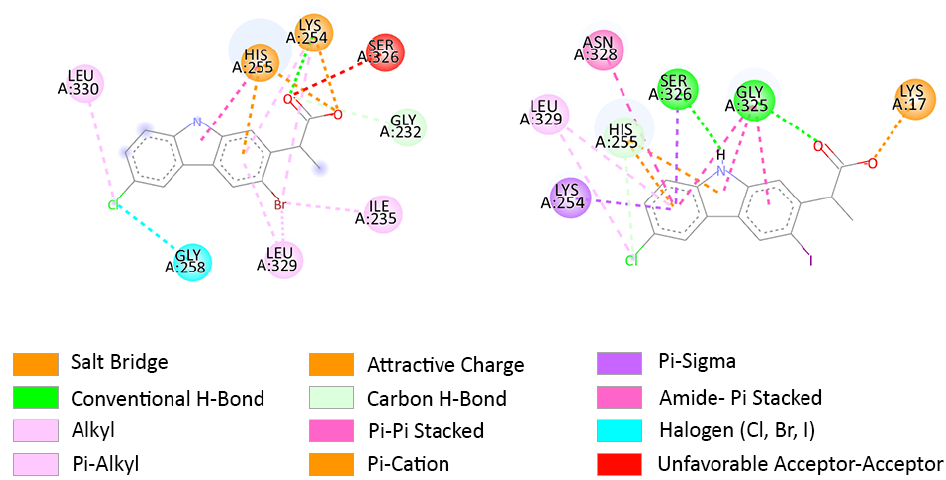
Figure 15. Predicted interactions between compounds 2 ( left ) and 3 ( right ) in interaction with FtsA. Images were obtained using Discovery Studio Visualizer [33].